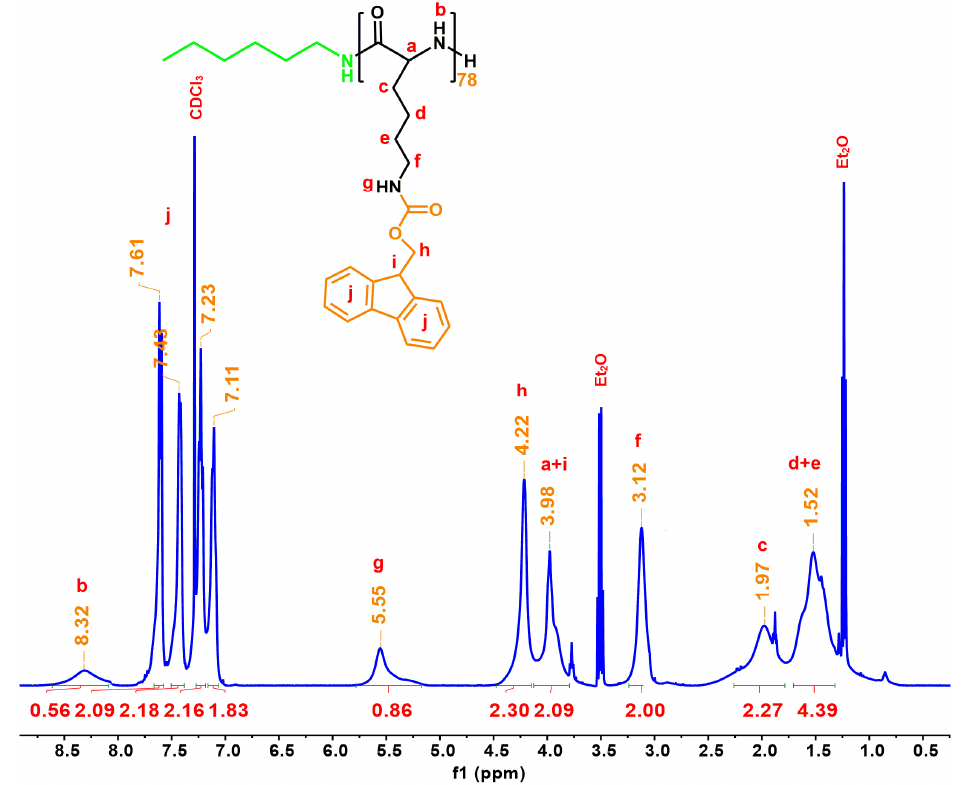
Polymers 2020 , 12 , x Figure 5. 1 H-NMR spectrum of the protected Poly( N ε -Fmoc- l -Lysine) 78 homopolymer in CDCl 3 . Figure 5. 1 H-NMR spectrum of the protected Poly( N ε -Fmoc- L -Lysine) 78 homopolymer in CDCl 3 .